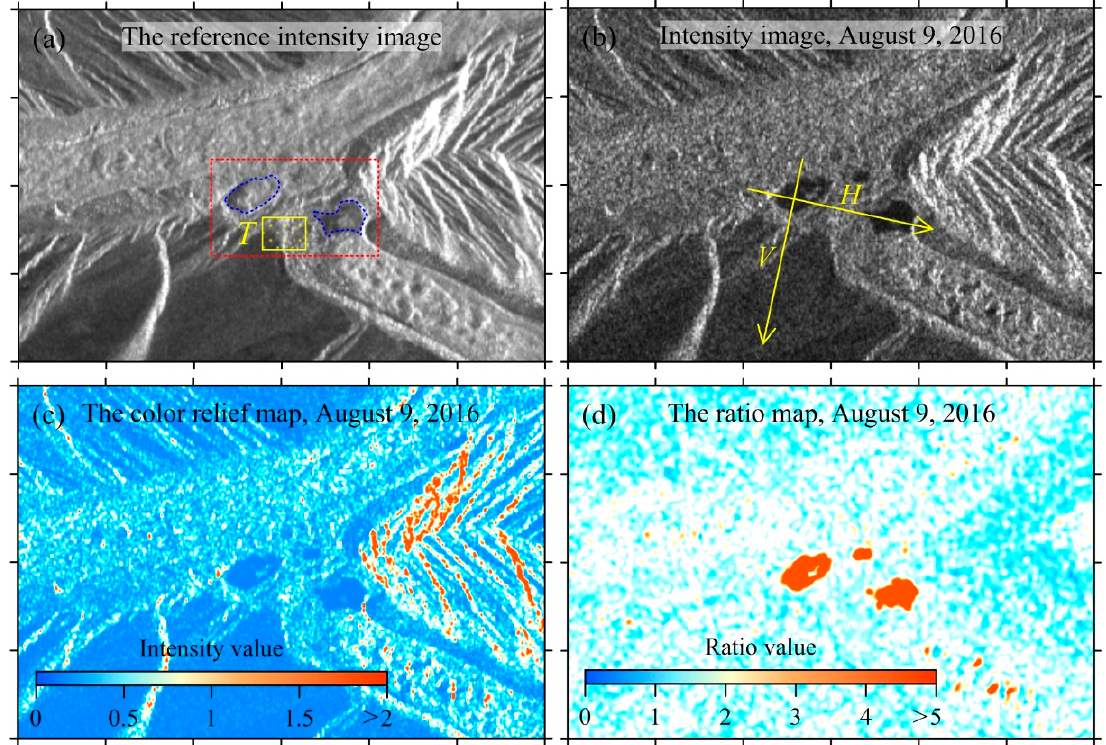
Figure 3. ( a ) The generated reference intensity image, the blue dotted lines indicate the shapes of XGL and DGL. ( b ) The intensity map in the 8-bit format acquired on 9 August 2016, the yellow lines indicate the position of profiles corresponding to Figure 4. ( c ) The intensity color relief map corresponding to ( b ). ( d ) The ratio color relief map for 9 August 2016.